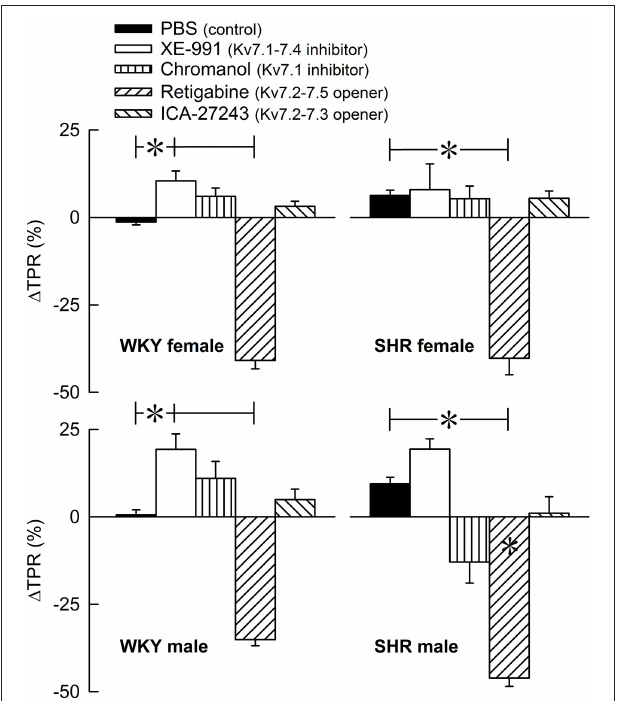
FIGURE 2 | The acute TPR-response to Kv7 inhibitors/openers. The rats were injected with vehicle (PBS) in the controls, and XE-991, chromanol, retigabine, or ICA-27243 in the experimental groups, as indicated by the symbol legends. 1 TPR was recorded at the time of maximum change from baseline. Comparisons were made between corresponding PBS-control and experimental groups, and for corresponding experimental groups across sex (none detected) or strain (*within column). Analyses were done by one-way ANOVA, followed by Student’s two-sample t -tests or Kruskal–Wallis tests. * P ≤ 0.0125.